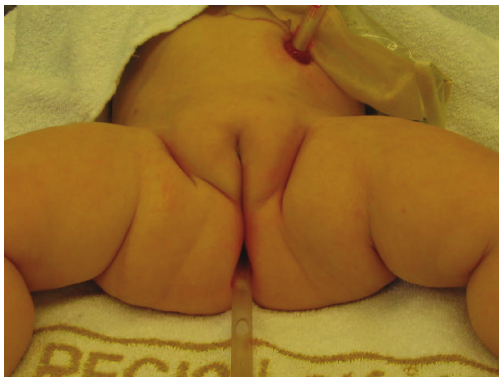
Figure 6: The endoscope was pressed against the rectal atresia, and with the help of external pressure, the endoscope could be seen 1 cm up in the anal channel.